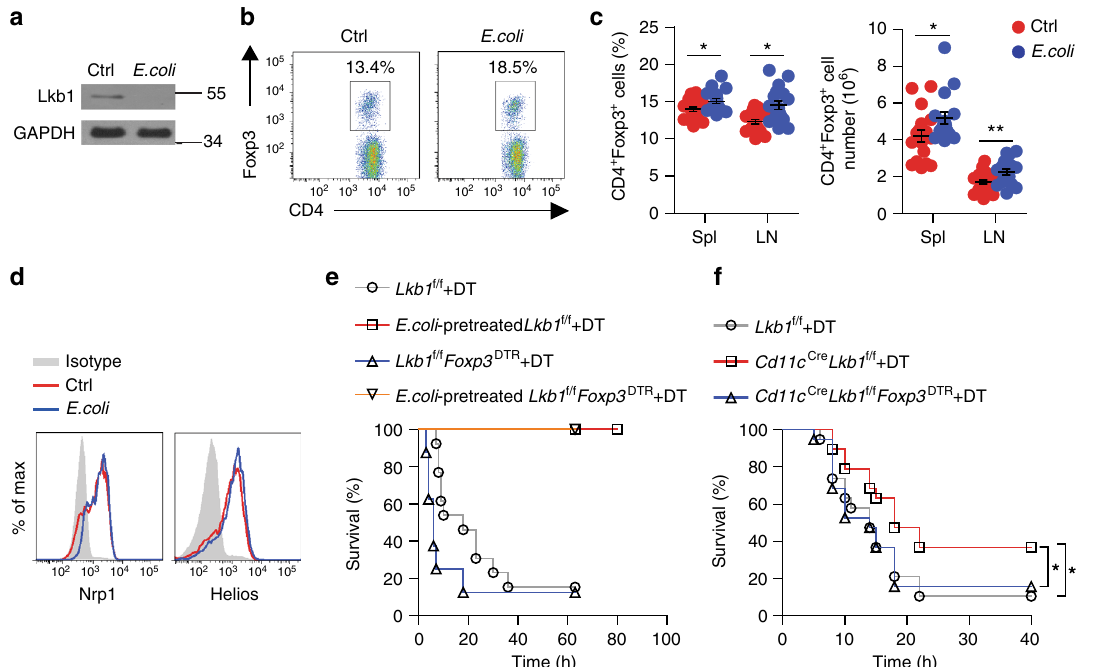
Fig. 7 E. coli infection induces T reg cell expansion and suppression through depleting Lkb1 in DCs. a Immunoblot analysis of Lkb1 protein in DCs from C57 mice challenged with or without E. coli (1×10 7 ) via intraperitoneal injection overnight. b Flow cytometric analysis of splenic T reg cells from C57 mice treated with or without E. coli (1×10 7 ) 5 days in advance. c Percentage and absolute number of T reg cells in the spleen and LNs of C57 mice treated with or without E. coli (1×10 7 ) 5 days in advance (Ctrl, n = 18; E. coli , n = 17). d Flow cytometric analysis of Nrp1 and Helios expression on splenic T reg cells from C57 mice challenged with or without E. coli (1×10 7 ) 5 days in advance. e The survival curve of Lkb1 f/f ( n = 13 each group) and Lkb1 f/f Foxp3 DTR mice ( n = 8 each group) pre-treated with or without E. coli (1×10 7 , 5 days in advance), treated with DT (50 μ g kg − 1 , 2 days in advance), and then challenged with a lethal dose of E. coli (1×10 8 ). f The survival curve of Lkb1 f/f mice, Cd11c Cre Lkb1 f/f mice, and Cd11c Cre Lkb1 f/f Foxp3 DTR mice treated with DT (50 μ g kg − 1 , 2 days in advance) and challenged with a lethal dose of E. coli (1×10 8 ) administered by intraperitoneal injection ( n = 19 each group). Each symbol ( c ) indicates an individual